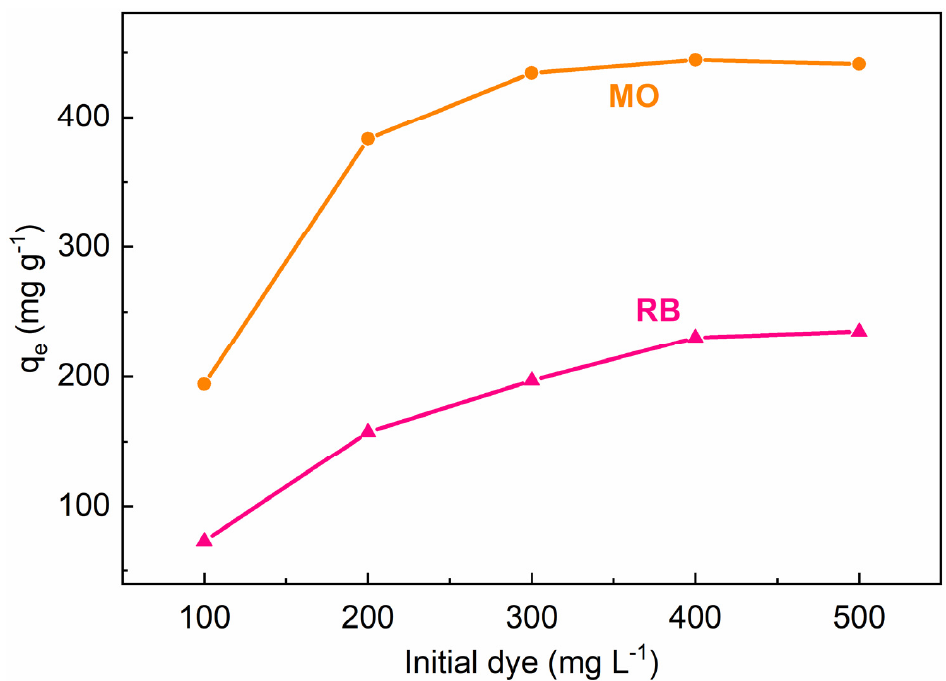
Figure 3. Adsorption uptakes of 160-MIL-101 toward MO and RB after 24 h, as determined by dispersing 5 mg of 160-MIL-101 in the aqueous dye solution (100 mg L − 1 to 500 mg L − 1 ) at ambient temperature (25 °C).